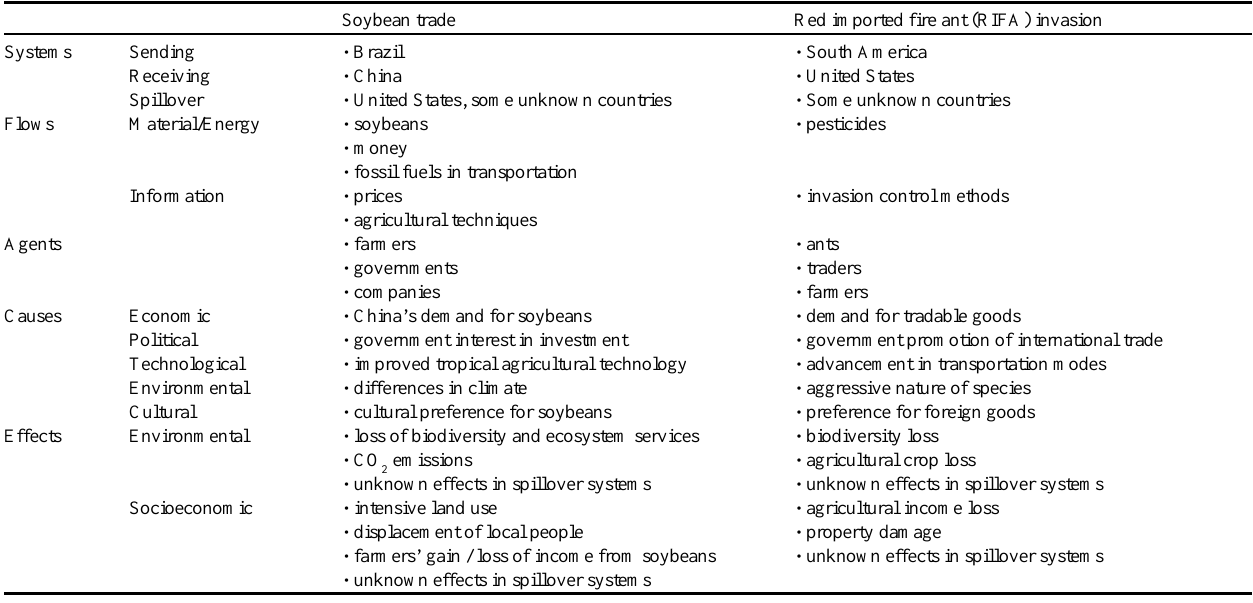
Table 1 . Summary of five major components in the two examples (Soybean trade between Brazil and China, and Red imported fire ant [RIFA]